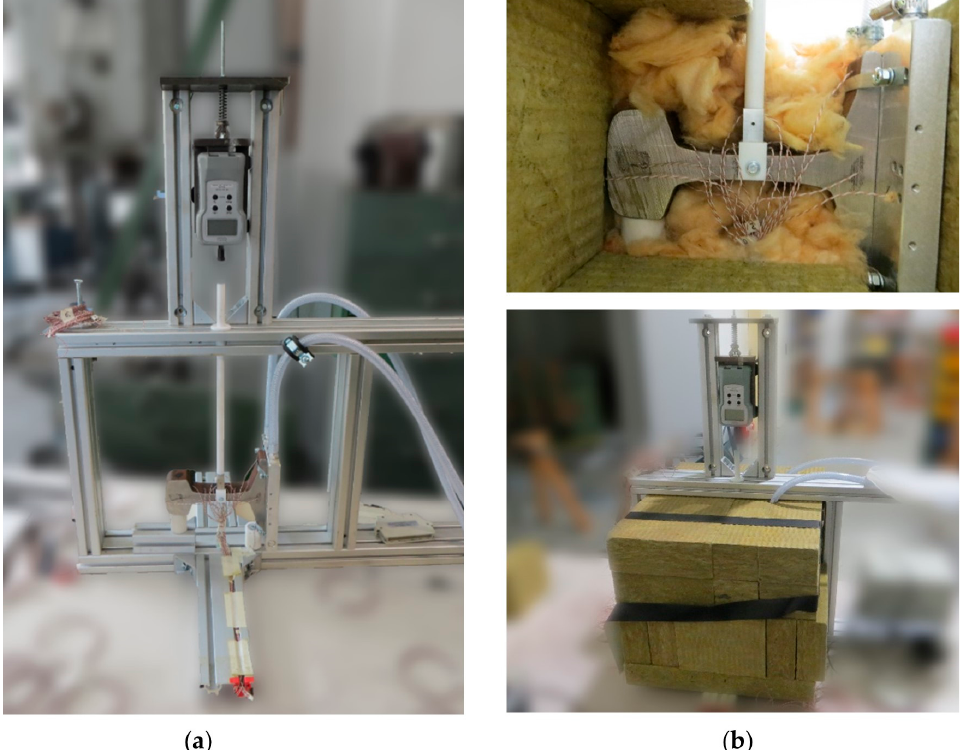
Figure A2. ( a ) Mechanical test setup for measuring the thermal contact resistance dependent on joint force; ( b ) Thermal insulation realized with rock wool and glass wool.